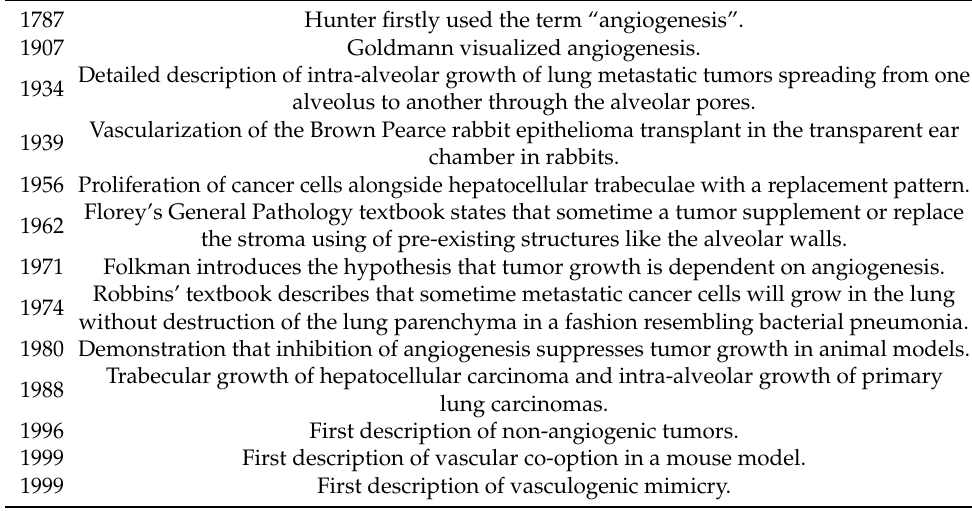
Table 1. A brief timeline of the relationship between blood vessels and